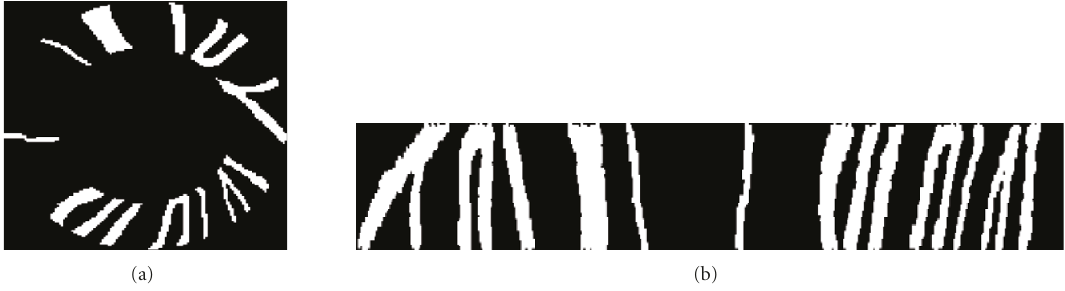
Figure 10: Polar transformation: (a) ROI in Cartesian coordinates, (b) polar image.